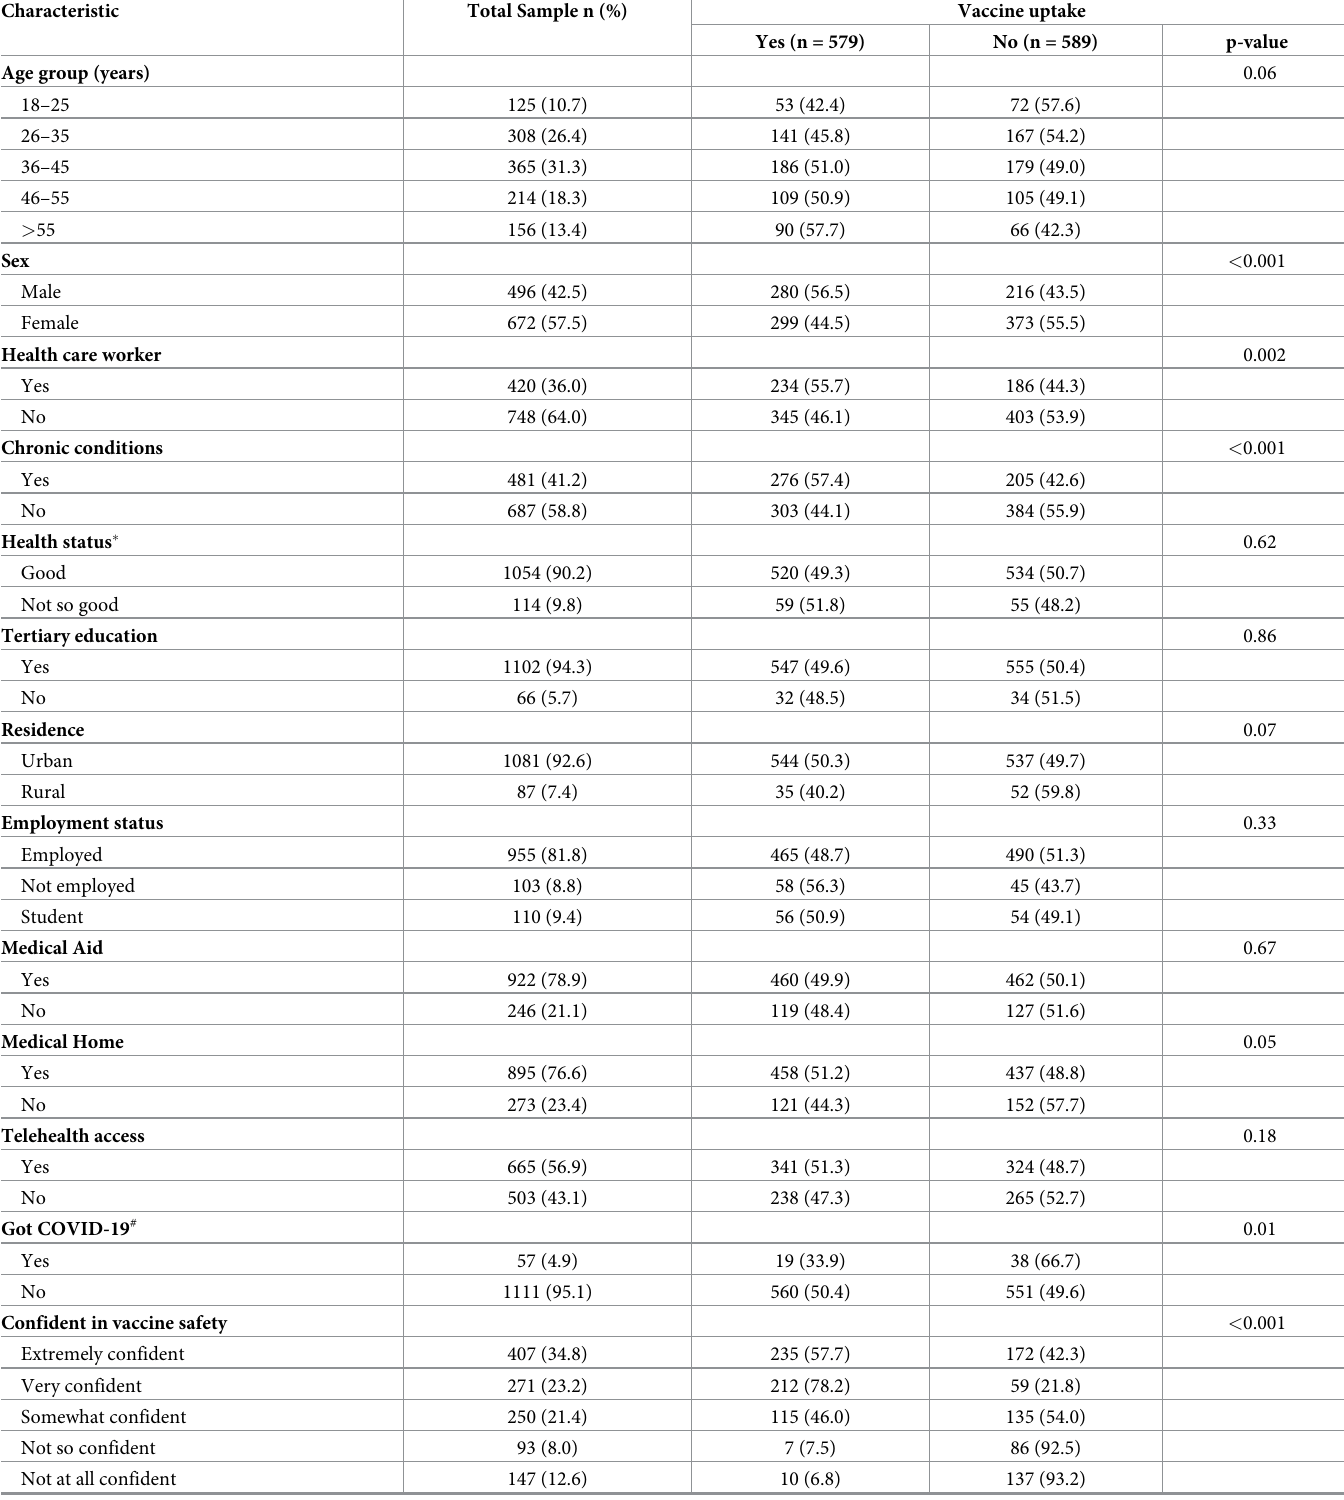
Table 1. Socio-demographic characteristics and vaccine